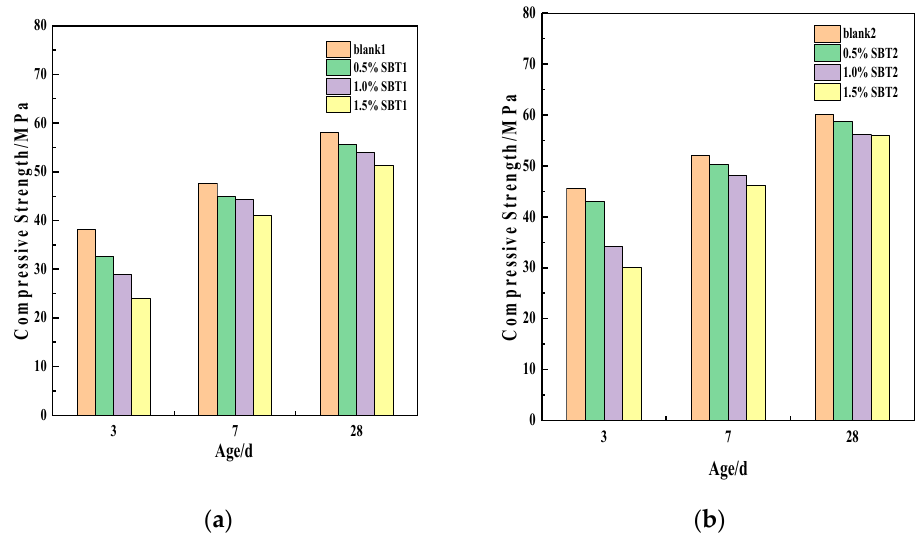
Figure 2. Compressive strength of concrete specimens at different ages. ( a ) is the compressive strength of concrete specimen under normal temperature curing; ( b ) is the compressive strength of concrete specimen under variable-temperature curing.